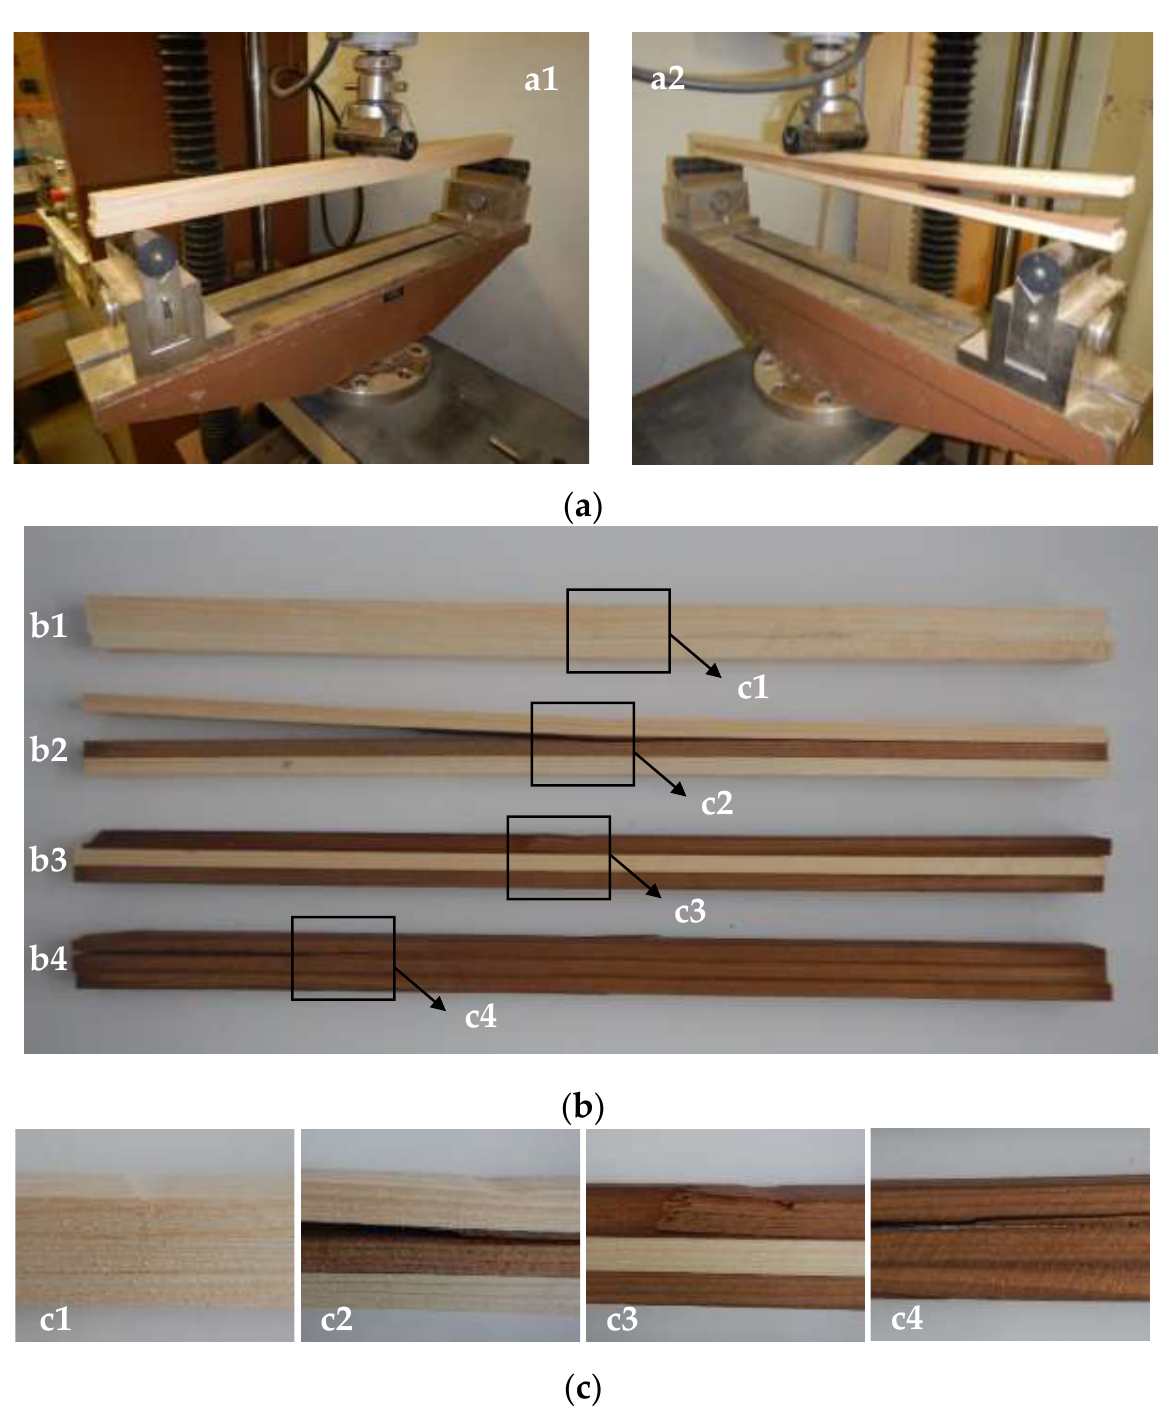
Figure 4. Examples of the 3-point bending test of three-layer glulam beams ( a : a1 = SSS; a2 = SAS, if A aged at T-200 °C), showing typical damages in the bond joints and/or wood lamellas ( b : b1 = SSS; b2 = SAS; b3 = ASA; b4 = AAA, if A always aged at T-220 °C) and details of these damages ( c : c1 to c4 ).